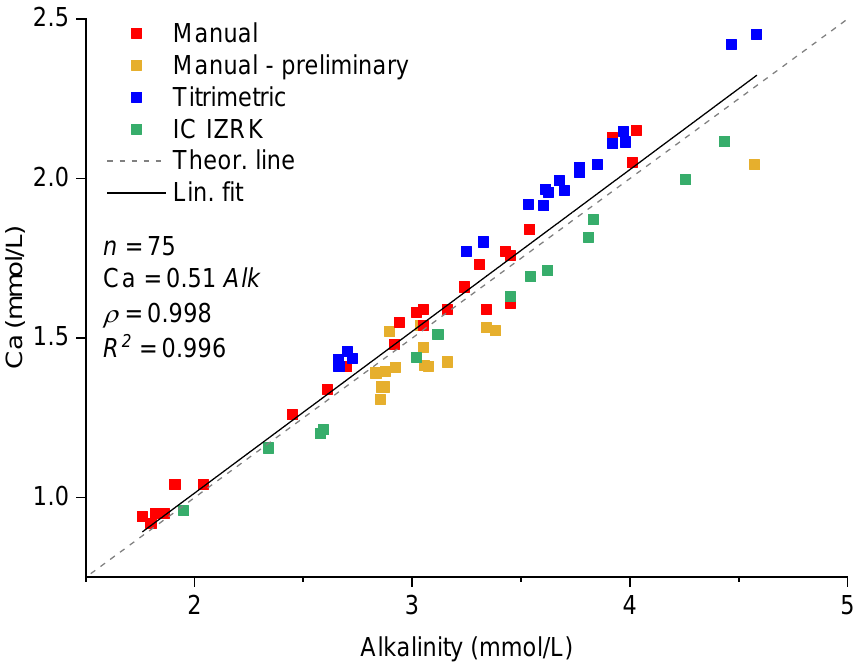
Figure 8. Linear correlation between the Ca concentrations and carbonate alkalinity for the samples where the Ca concentrations were measured manually, titrimetrically or via IC at IZRK. The linear relationship was used to calculate the Ca concentrations in incorrectly analysed samples. The similar slope of the theoretical line (pure Ca(HCO 3 ) 2 solution; dashed line) and the fitted line (solid line) confirms that the water samples are indeed mostly of the Ca-HCO 3 type, regardless of the sampling site or the time period of sampling. However, a positive deviation of the Ca concentration can be seen in the samples analysed with the titrimetric method and a negative deviation in the samples analysed with the IC, the causes of which are unknown. (Figure 9). The parameters showed general seasonal variations with a few exceptions (see Discussion in Section 4.2.1). In the cooler months, the dissolved ion concentrations (Alk, Ca and SEC) were the lowest, while the pH and SI cc values were the highest. In the warm summer months, the samples had higher solute loads (alkalinity, Ca and SEC) and a wide range in SI cc (from − 0.5 at RD to 0.5 at the control sites). The control drips were the least variable, showing almost constant values for the Ca, alkalinity and SEC but minor fluctuations in the pH and SI cc . The SI cc values of the control drips never fell below zero. The average value of the alkalinity was highest in the control drips at PP (4.3 mmol/L) and much lower in the RD drips (2.8 mmol/L). Similar extremes were found for the Ca concentrations (2.2 mmol/L for the control group and 1.5 mmol/L for the RD drips) and SEC (from 389 µ S/cm to 291 µ S/cm). Differences between the RD drips and controls occurred throughout the year, regardless of the season, which was already observed